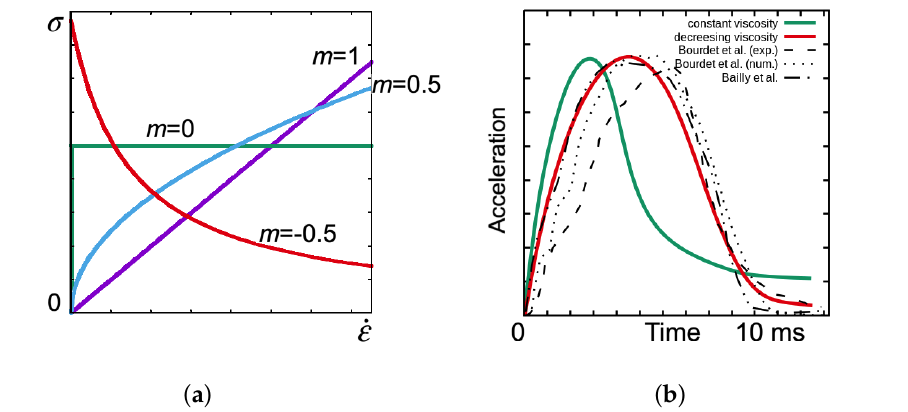
Figure 4. Norton–Hoff material response for different rate sensitivity m ( a ) and the resulting accelera- tion over time, compared with reference literature results [15,18] ( b